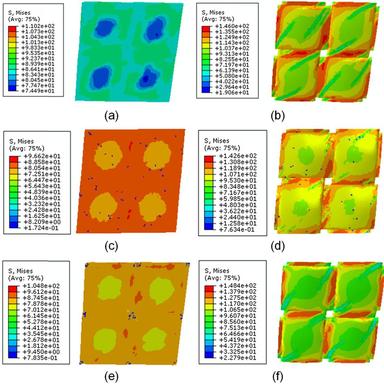
Von Mises stresses contour of yarn and matrix: (a) Stresses contour of FE_M; (b) Stresses contour of FE_D; (c) Stresses contour of FE_C.